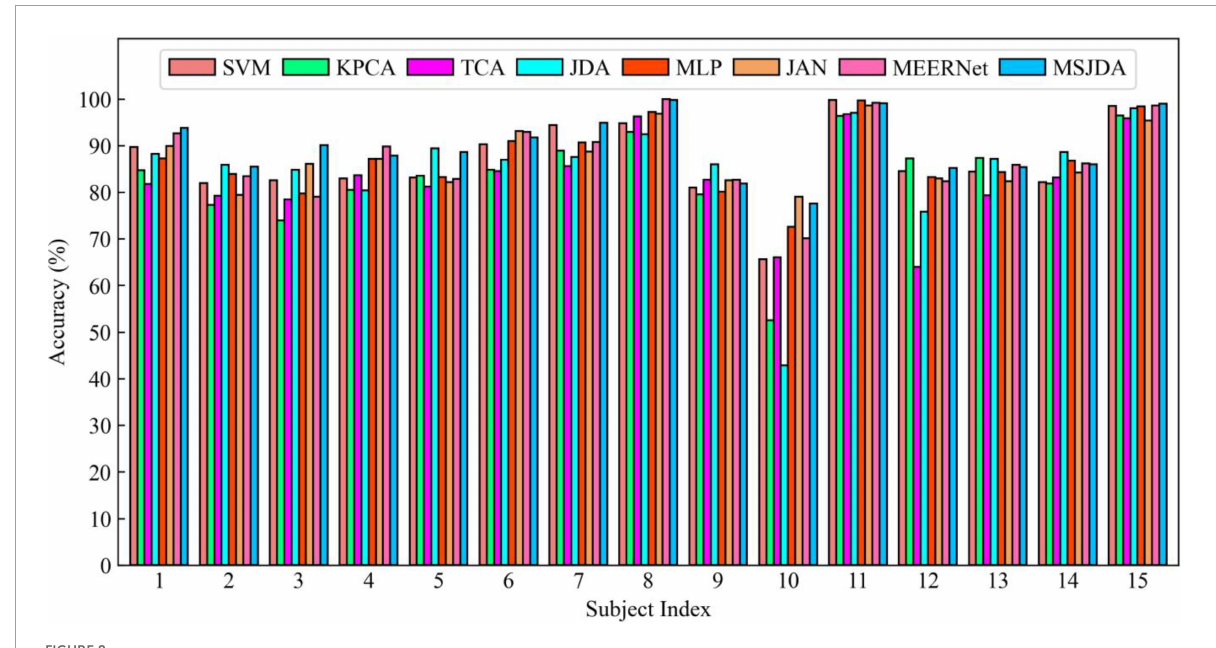
FIGURE8 Results of cross-session experiments for each subject being transferred from their respective source sessions to their third session.